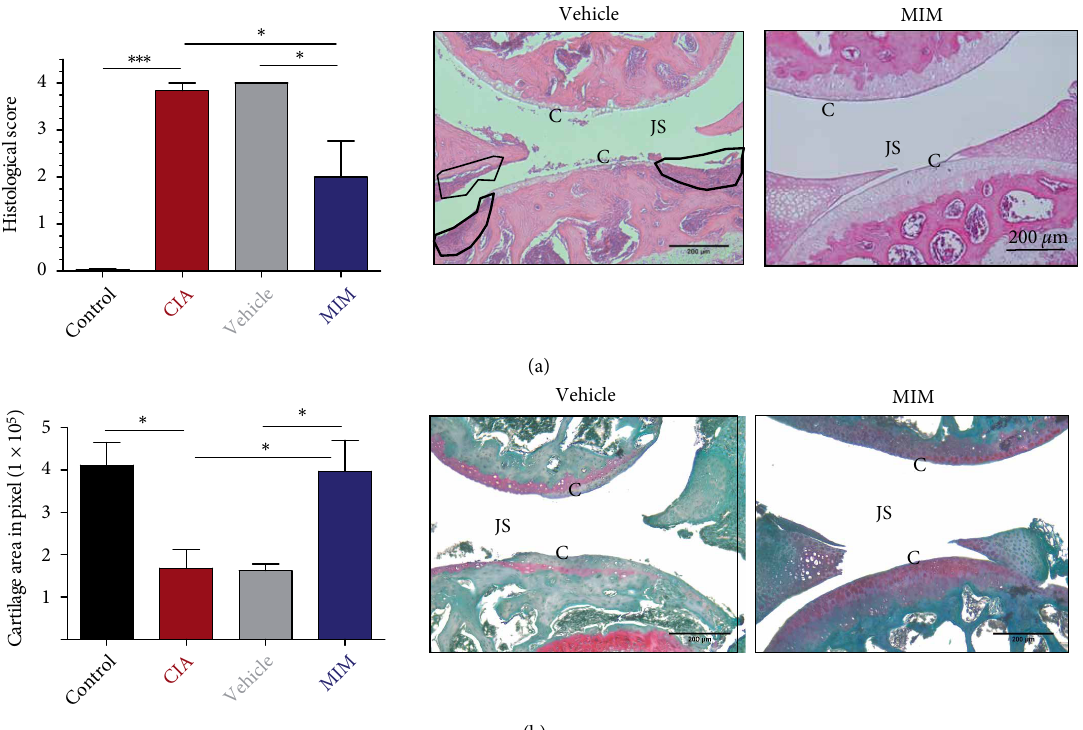
Figure 4: Histological examination of joints. (a) Histological score was determined based on arthritis severity observed in the sections of knee joints stained with H&E. (b) Quantification of cartilage area in pixel and representative histologic sections of knee joints of three animals per group stained with Safranin-O. The stained cartilage appeared red in color. Representative histologic sections for CIA + vehicle and CIA + MIM are shown next to each graph. More representative histologic sections are shown in Supplementary Materials, see Figures S1 and S2. C = cartilage layer; JS = joint space; black circles indicate inflammation and synovial hyperplasia (pannus formation). Bars in graphs represent mean ± SEM of 3 mice per